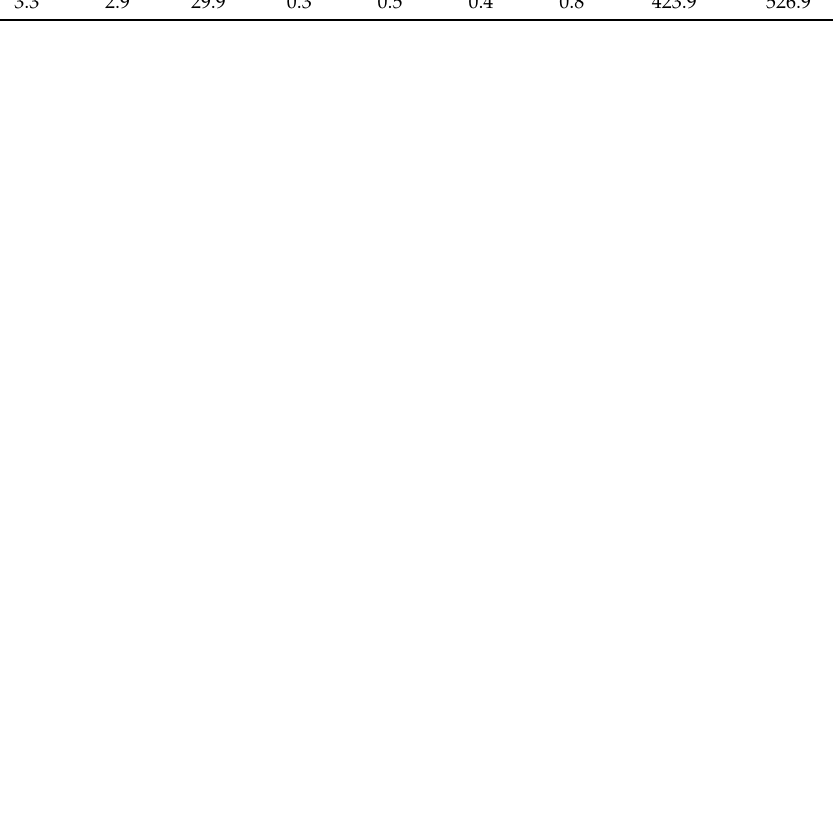
Figure 4. The crystal structures of adamantylated 4,5,6,7-tetrahalogeno-1 H -benzimidazoles with d norm (left; colour scale: negative (red) to positive (blue) values), shape index (centre; concave (red) and convex (blue) regions) and curvedness (right; the planar (green) and curved (blue edge) regions) over total 3D Hirshfeld surface: ( a ) AB, ( b ) tClAB, ( c ) tBrAB and ( d ) tIAB.